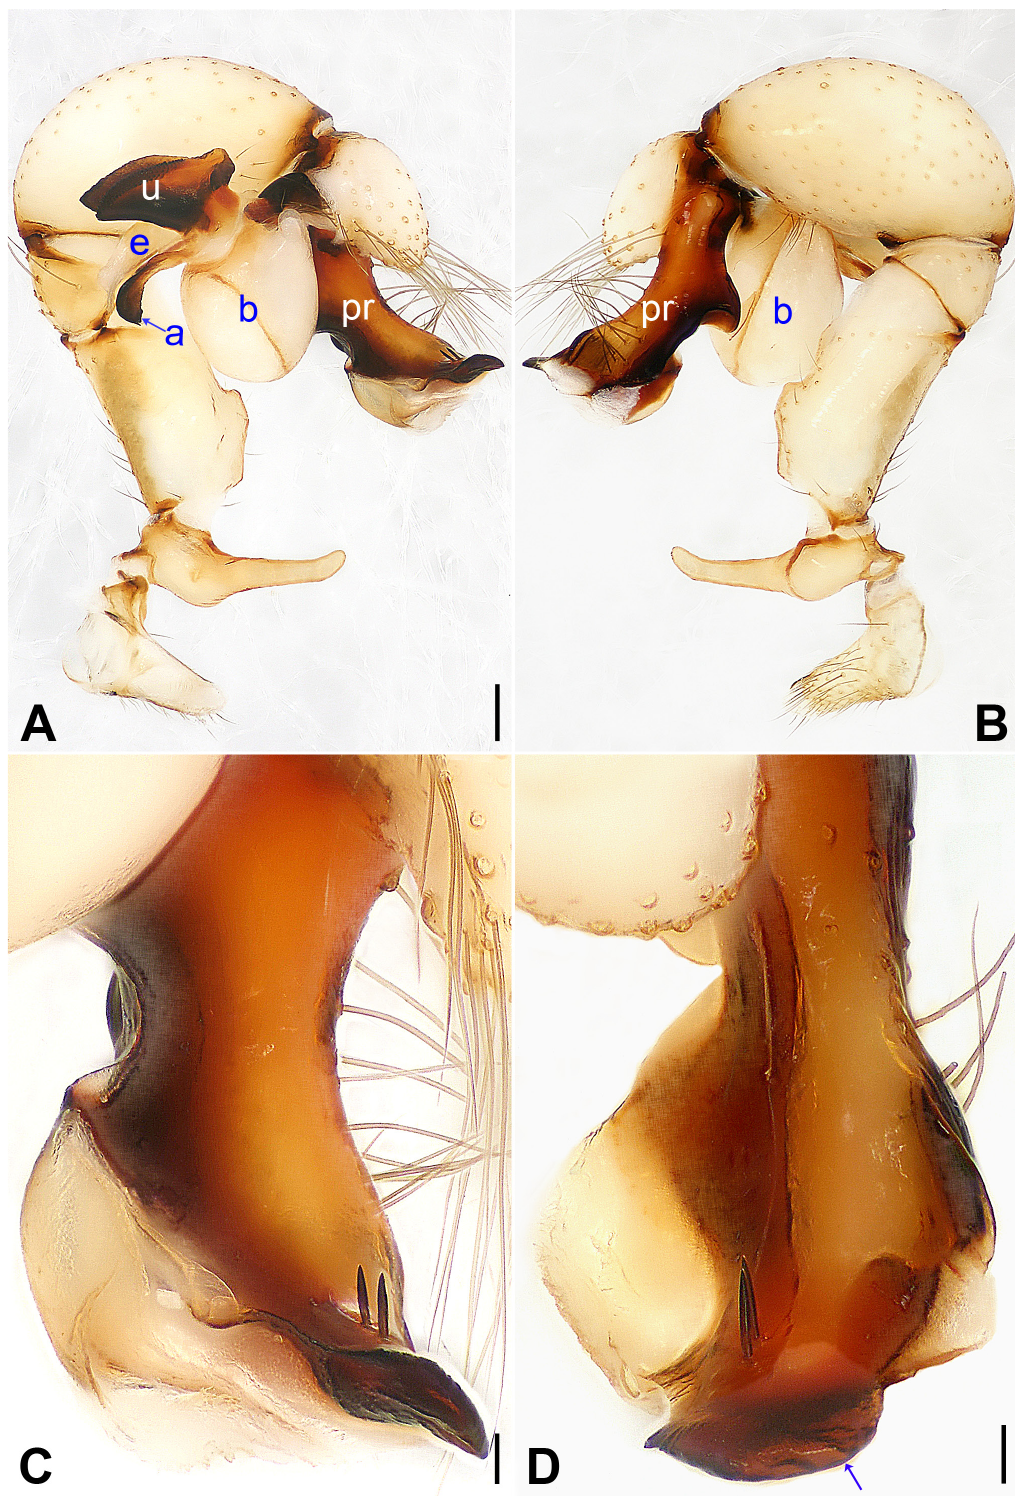
Fig. 1. Pholcus saidovi Yao & Li sp. nov., holotype, ♂. A–B . Pedipalp (A. Prolateral view. B. Retrolateral view). C–D . Distal part of procursus (C. Prolateral view. D. Dorsal view, arrow points at blunt dorsal apophysis distally). Abbreviations: a = appendix; b = bulb; e = embolus; pr = procursus; u = uncus. Scale bars: A–B = 0.20 mm; C–D = 0.05